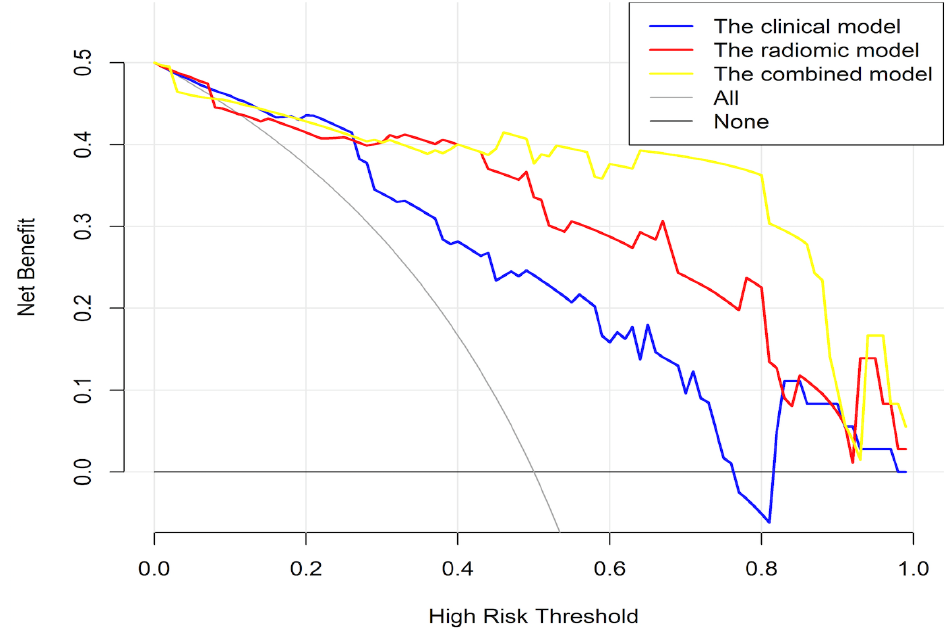
Figure 6. Decision curve analysis.